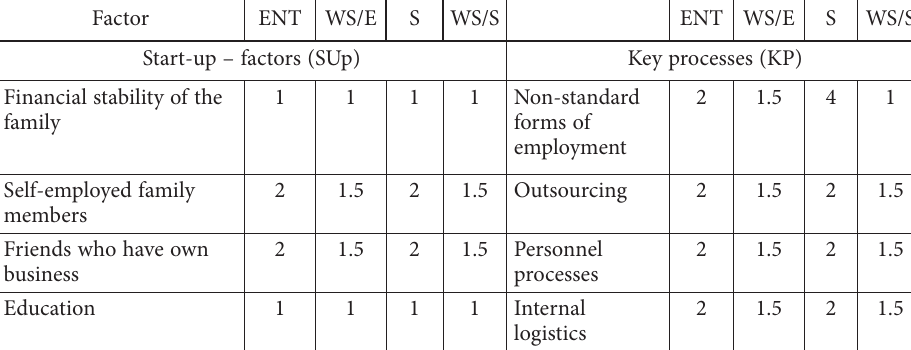
Table 9. Evaluation of Romanian competencies model (source: survey data mode values, differences are in bold, WS/S- weighted score students, WS/E- weighted score entrepreneurs) Factor ENT WS/E S